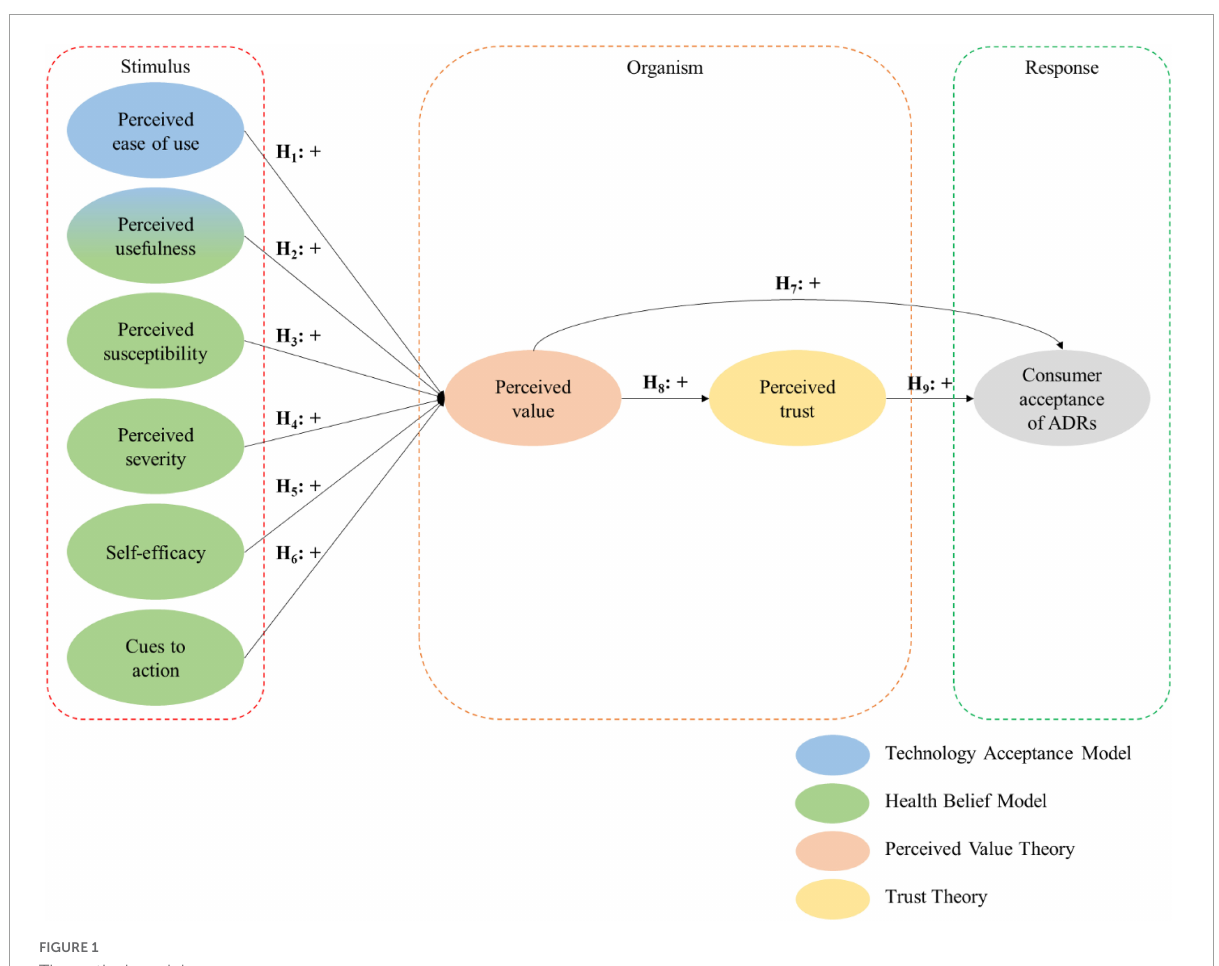
FIGURE1 Theoretical model.